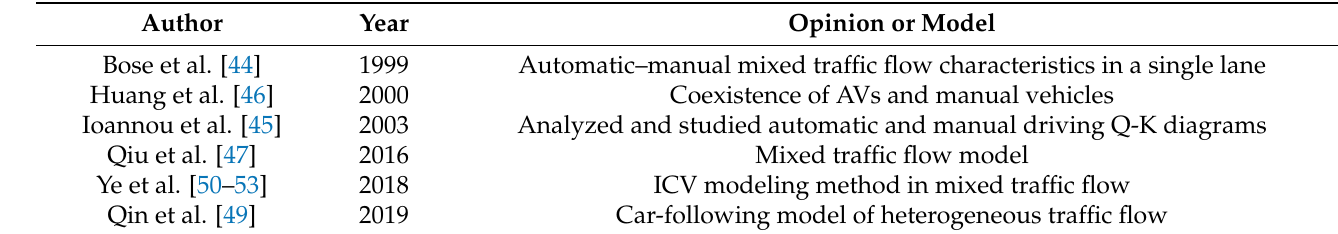
Table 5. Research summary of IoV driving behavior